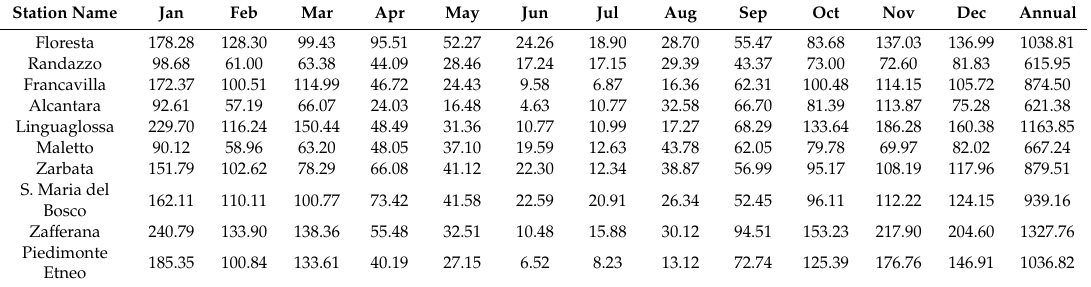
Table 4. Monthly and annual means of rainfall data (in mm) observed in the period 1981–2000.